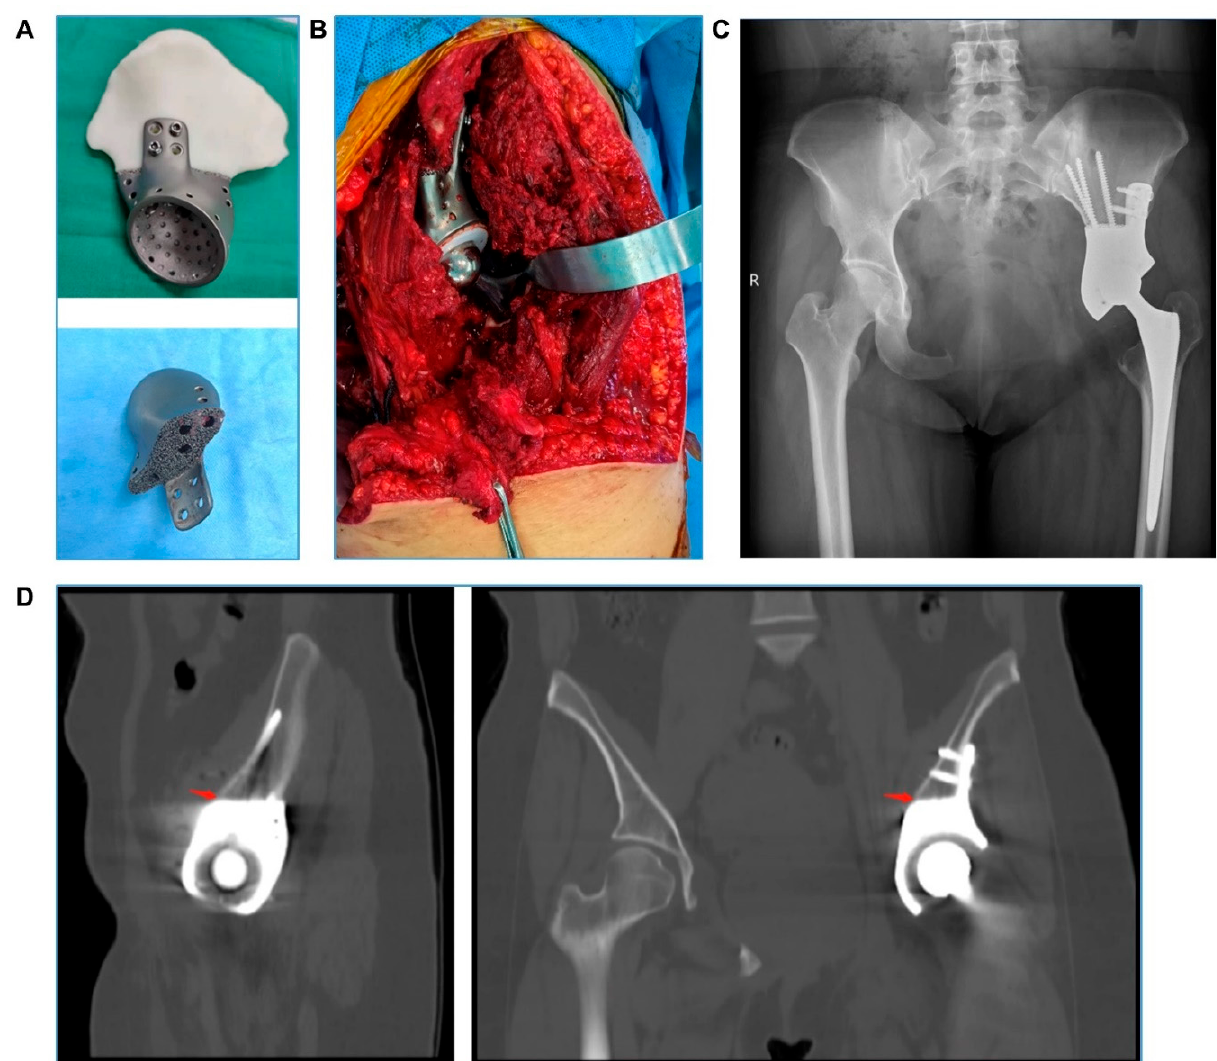
Figure 4. Case 3. Intra- and post-operative images. ( A ) Finished 3D-printed prosthesis: The porous side is clearly shown. ( B ) The 3D-printed prosthesis is installed and fixed. ( C ) X-ray shows a good implantation effect at the visit 3 months post operation. ( D ) CT shows good bone ingrowth and fusion at the prosthesis and bone interface (red arrow) at the visit 10 months post operation.